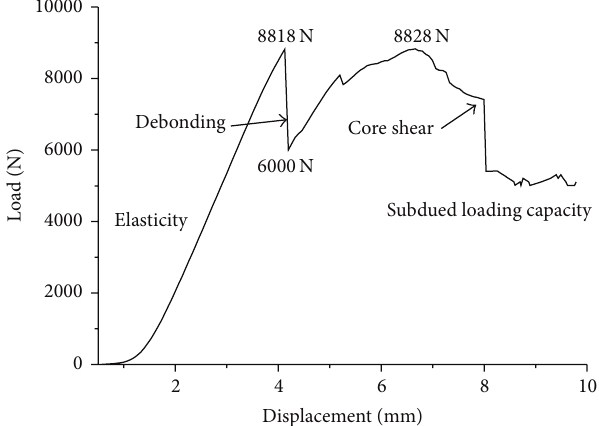
Figure 9: Load-deflection curve of triangular grid sandwich struc- ture (specimen